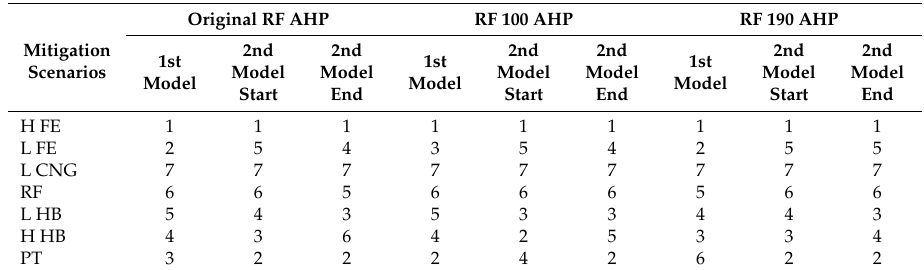
Table 5. A comparison of ranking orders of mitigation scenarios in the first and second decision- making models.